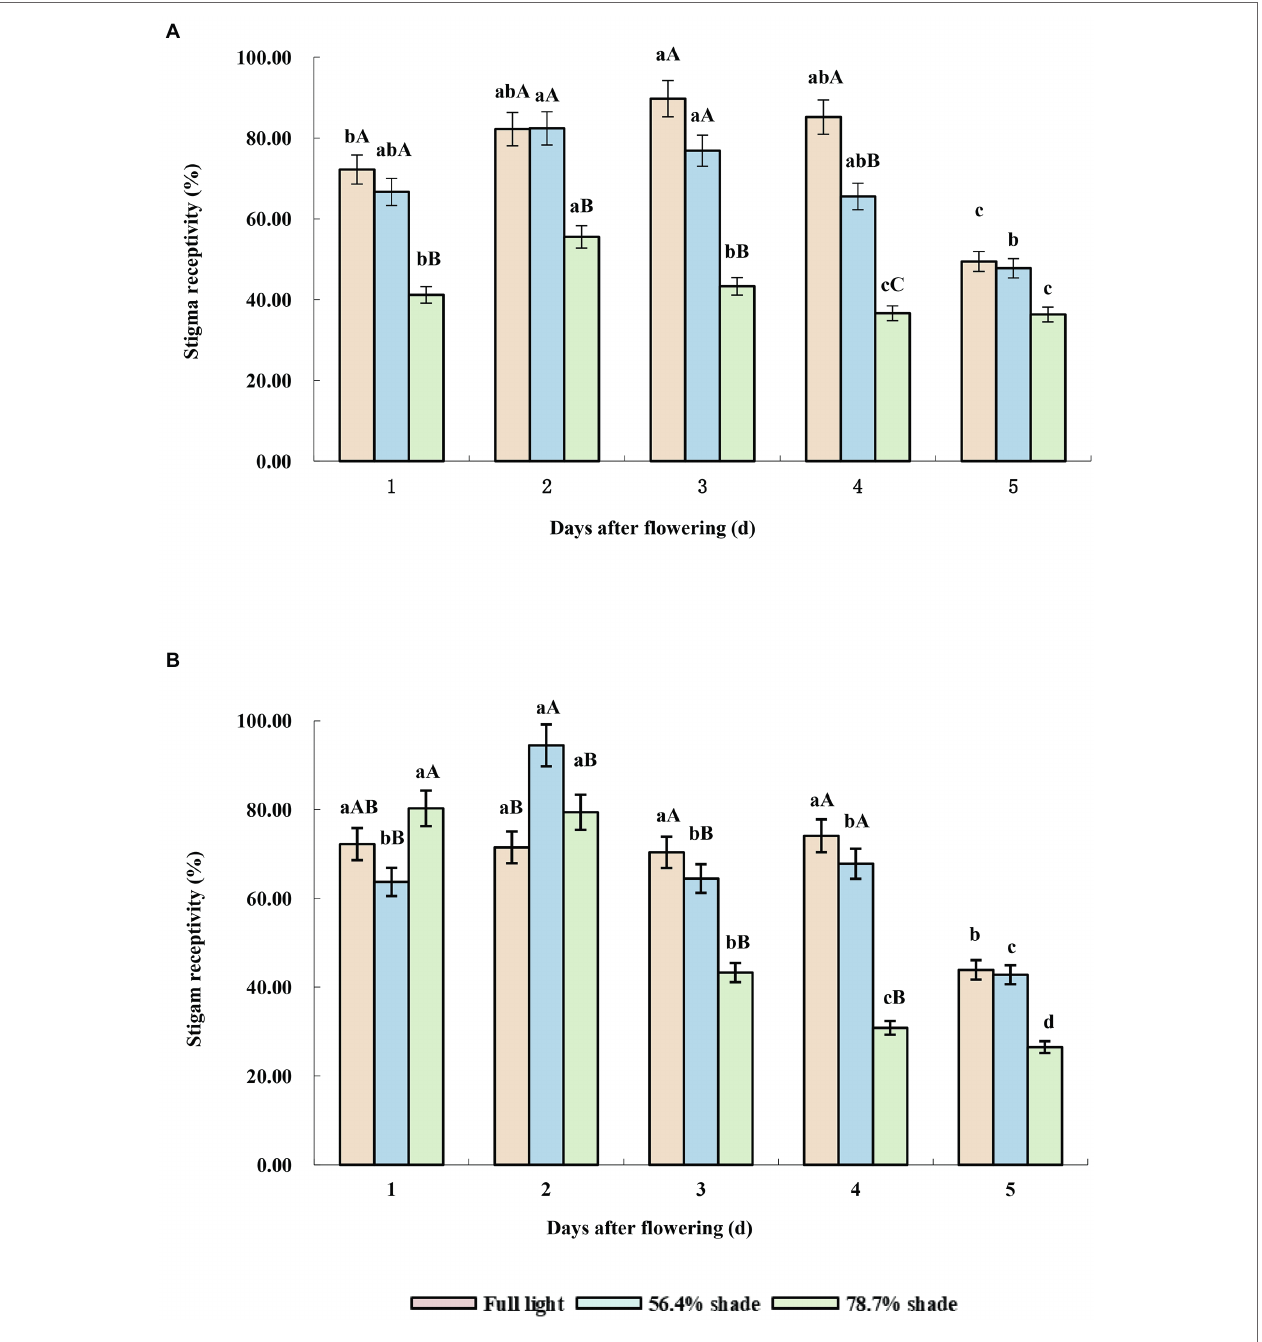
FIGURE 3 | Stigma receptivity of the two alfalfa cultivars under different shading levels. (A) Victoria, (B) Eureka. Different capital and lower case letters indicate significant difference under different shading levels and days after flowering at 0.05 level ( p < 0.05),